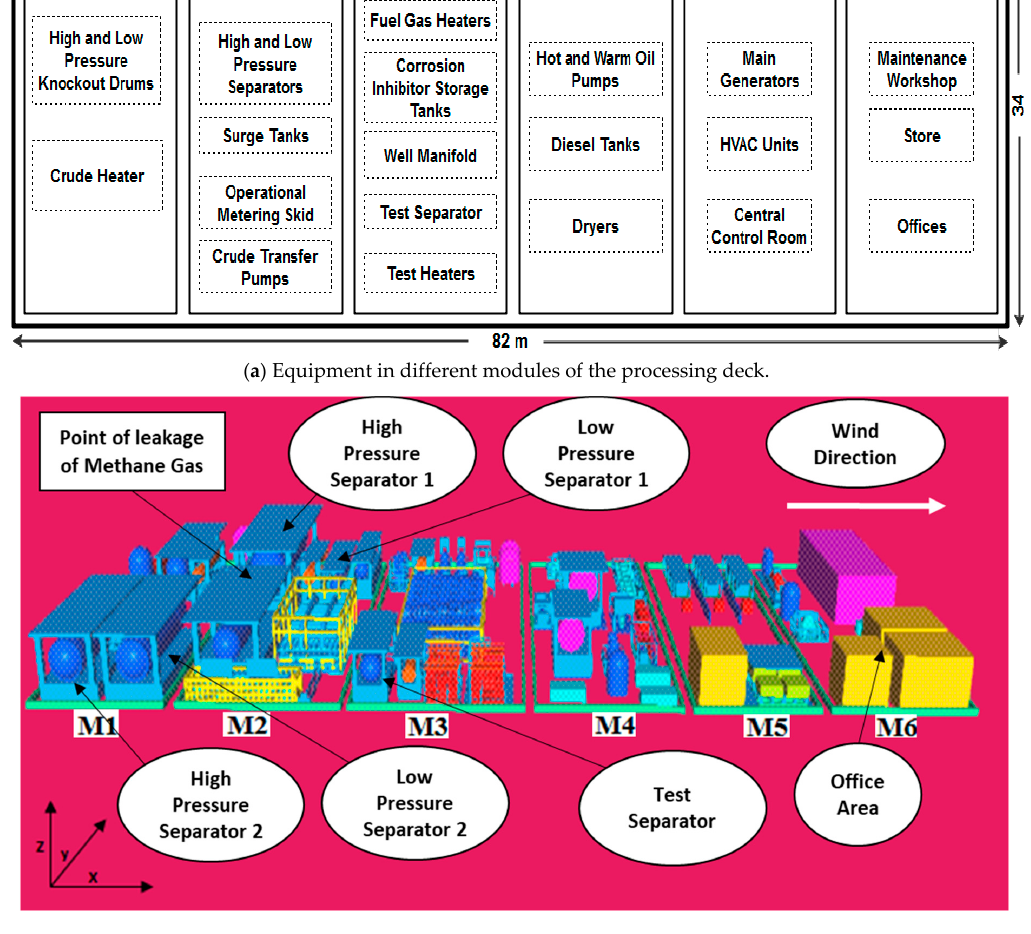
Figure 2. Processing deck of an offshore facility. Reproduced with permission from Niazi et al. [33],